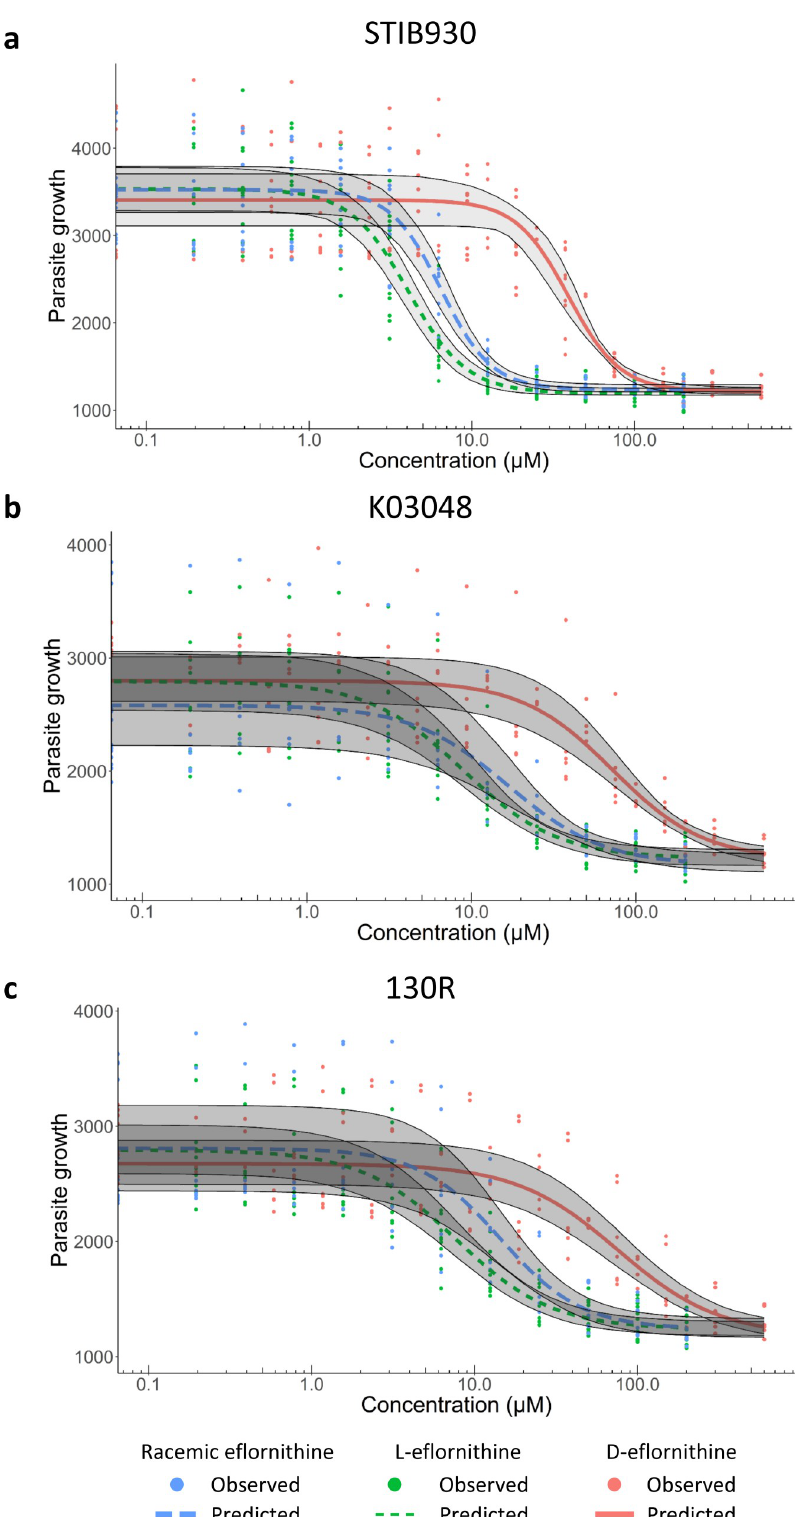
Fig 1. Antitrypanosomal in vitro activity for racemic eflornithine and its enantiomers against three different T . b . gambiense strains. In vitro activity for racemic eflornithine (blue), L-eflornithine (green) and D-eflornithine (red) against T . b . gambiense strains a) STIB930, b) K03048 and c) 130R. Parasite growth values are shown as